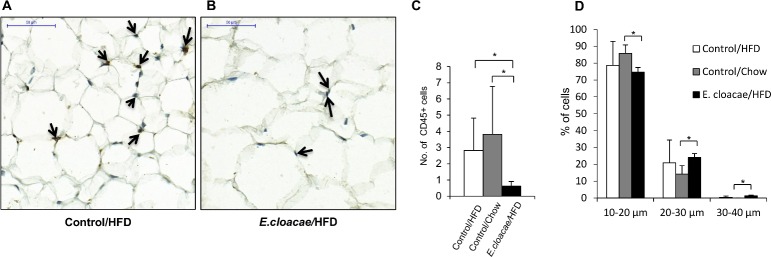
E.cloacae adminstration decreases the number of leukocytes and increases the size of adipocytes.(A) and (B) The histological images present the adipose tissues with CD45-staining indicated with arrows. (C) The relative numbers of CD45-positive cells as determined with manual cell counting from the stained tissues, represented as average cell numbers per field of view. (D) The percentages of adipocytes with diameters of 10–20 μm, 20–30 μm and 30–40 μm in each group. 500 cells were randomly selected from each sample. All data are presented as mean ± SD. n was 5-6/group. The statistical significance was set to p<0.05 and the significant differences are presented with lines and * between the groups.